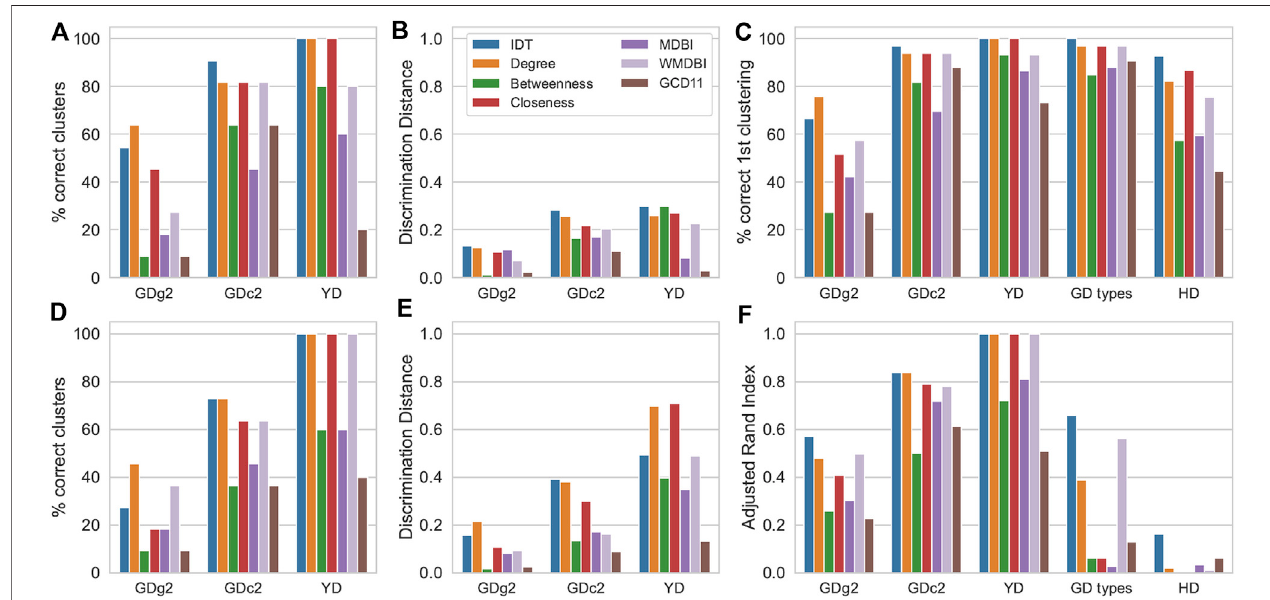
FIGURE 3 | Effect of IDT and sMDiN graph property analysis on clustering performance. (A) Correct clustering in HCA; (B) discrimination distance in HCA; (C) correct fi rst clustering in HCA; (D) correct clustering in K-means clustering; (E) discrimination distance in K-means clustering; (F) adjusted Rand Index in K-means clustering. Methods are as follows: intensity-based data pretreatment (IDT); network analysis: degree analysis (degree), betweenness centrality analysis (betweenness), closeness centrality analysis (closeness), MDB impact (MDBI), weighted MDB impact (WMDBI), and GCD-11 topology analysis